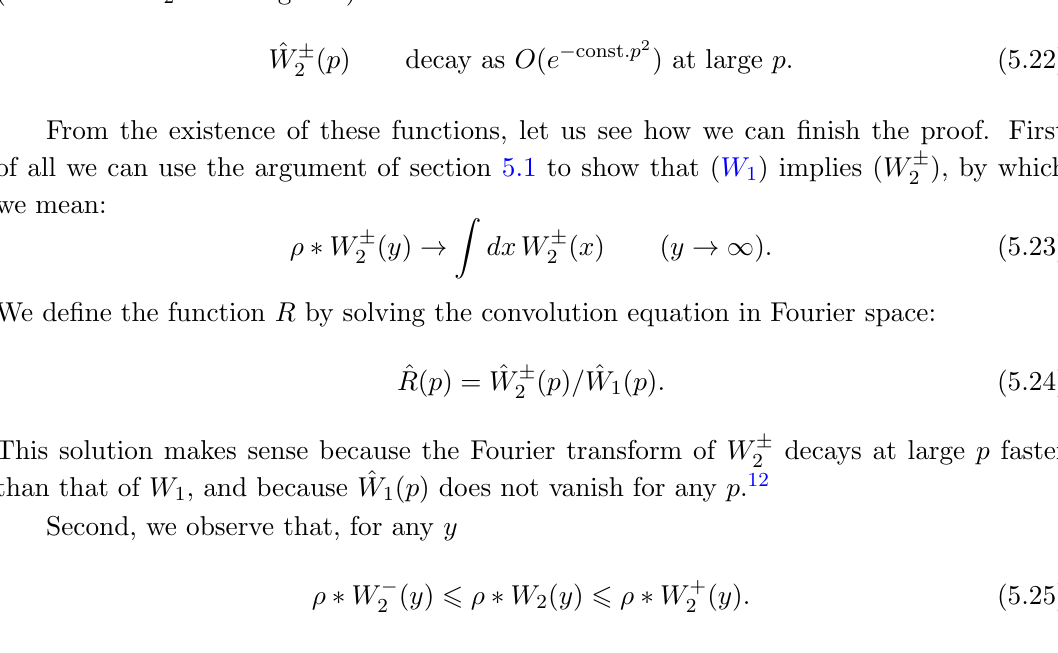
Figure 4 . Approximating the function W